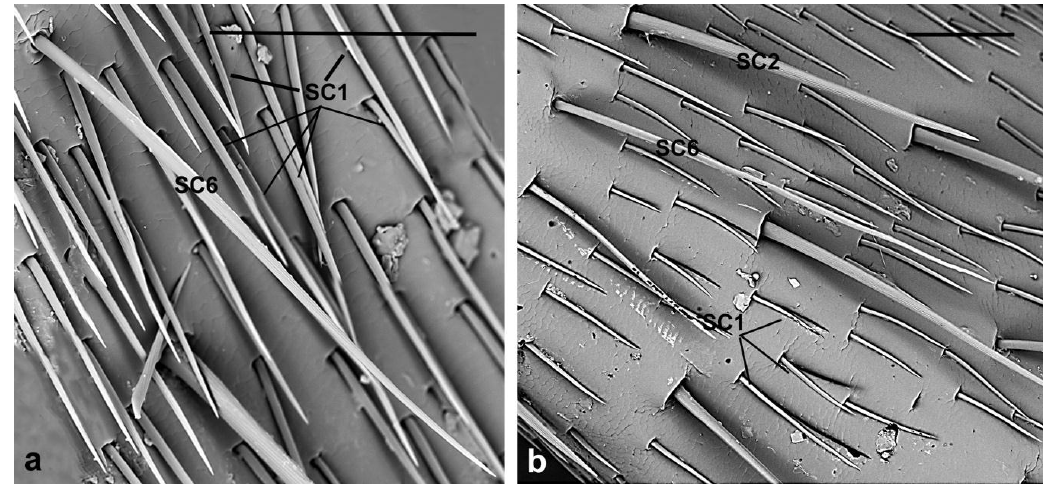
Figure 7. A. bungii , SEM. Sensilla chaetica SC6. ( a ) Female: Detail of one SC6 with a very long, thin shaft provided with longitudinal grooves and pointed tips. ( b ) SC6 in male. Abbreviations: SC1, sensillum chaeticum type 1; SC2, sensillum chaeticum type 2; SC6, sensillum chaeticum type 6. Scale bars: 100 µm.